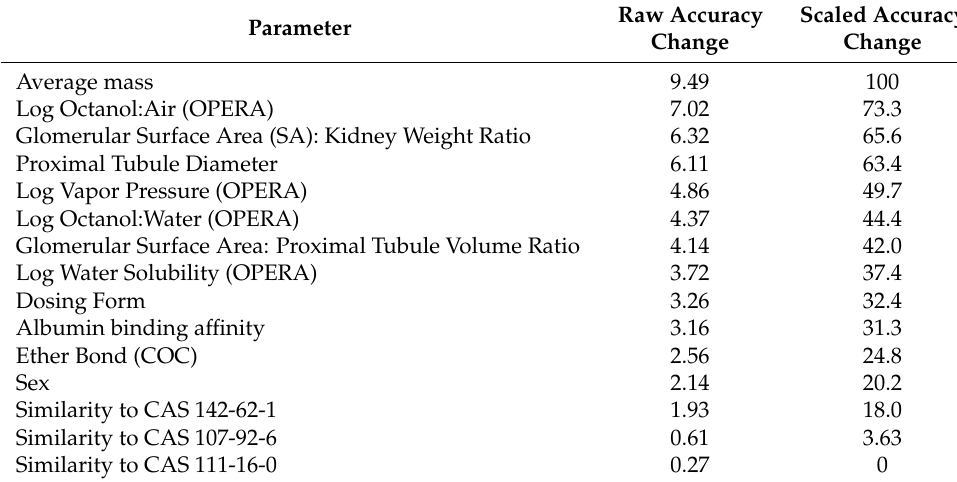
Table 3. Predictor Importance [109] (percent reduction in accuracy) of all model predictors.